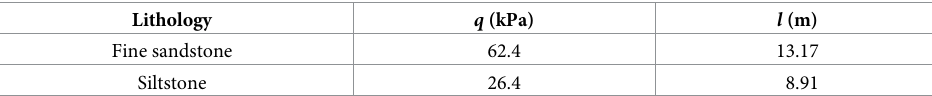
Table 11. Load and limited span result of each stratum above No.9 coal seam.